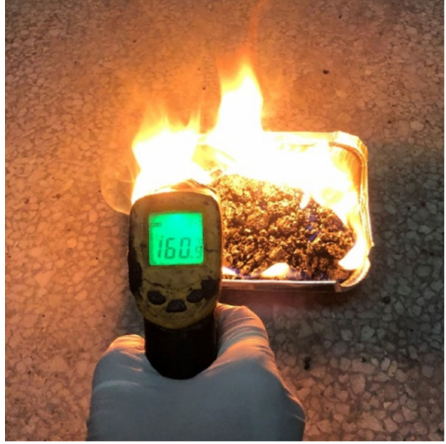
Figure 6. Combustion of the loose asphalt mixture using